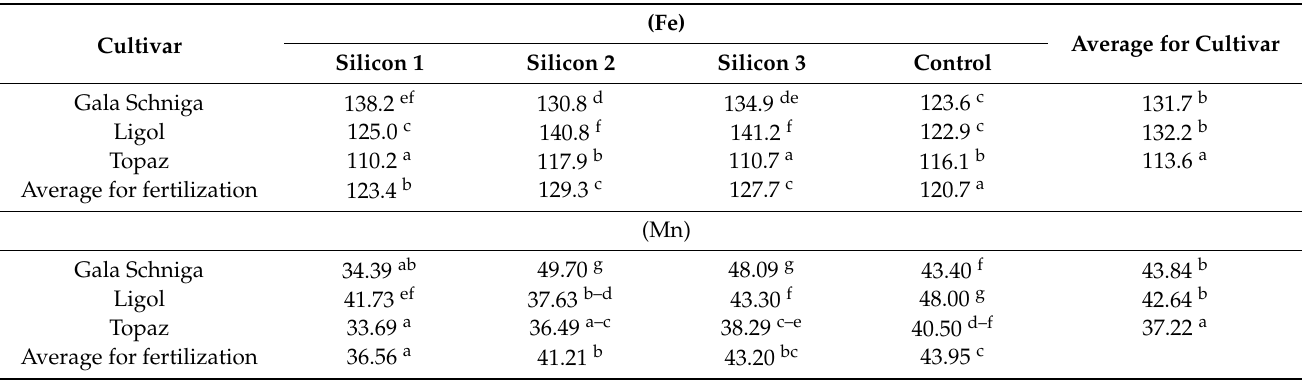
Table 14. The content of micronutrients in leaves of apple trees depend on the cultivar and foliar silicon treatment